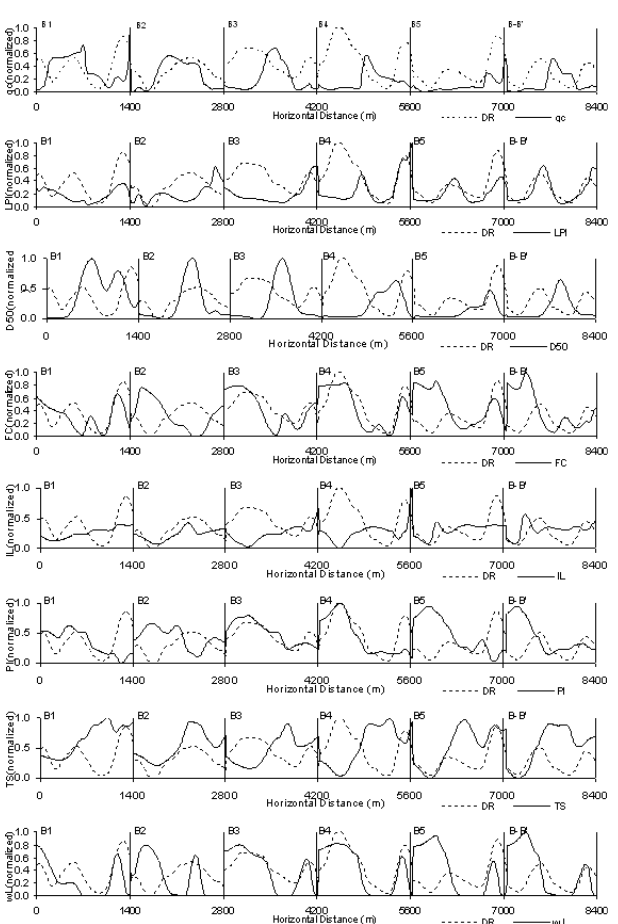
Fig. 6. Group B cross sections.